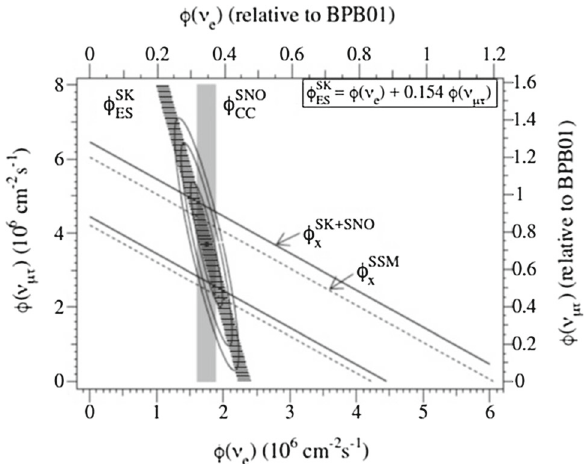
Fig. 11 The obtained ν e and ν μ.τ flux from the SNO charged current and Super-K ν + e scattering results (Fig. 3 from [60]). The apperance of non- ν e component in the solar neutrino measured on the earth is demonstrated at 3.3 σ